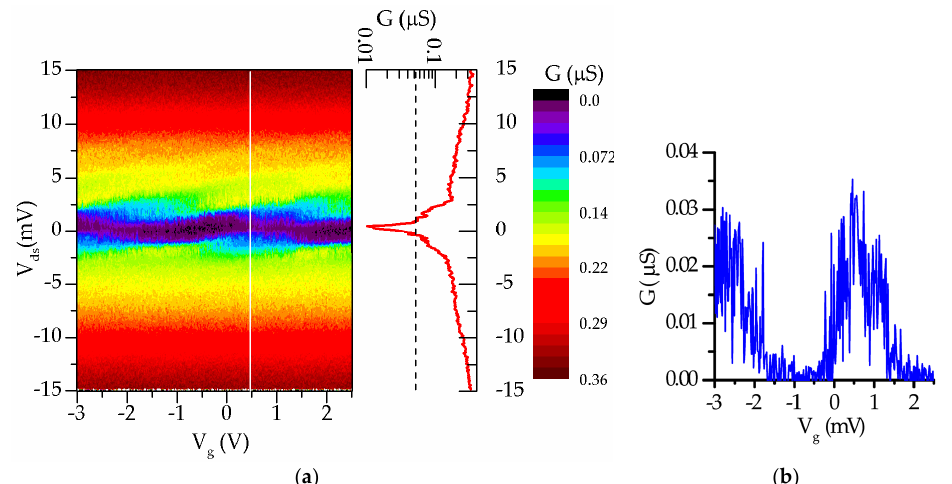
Figure 11. ( a ) Coulomb charging diagram of an Ni ‐ SiO 2 ‐ Ni SET in which the ALD dielectric (~1 nm of SiO 2 ) was exposed to remote hydrogen plasma (RHP) (measured at T = 0.4 K) along with a G ( V ds ) cross section (red curve) at a peak of CBO ( V g = 0.45 mV). Strong asymmetry, non ‐ MIM SET conductance out of blockade region, as well as “switching noise” are visible. ( b ) CBOs of the same device.